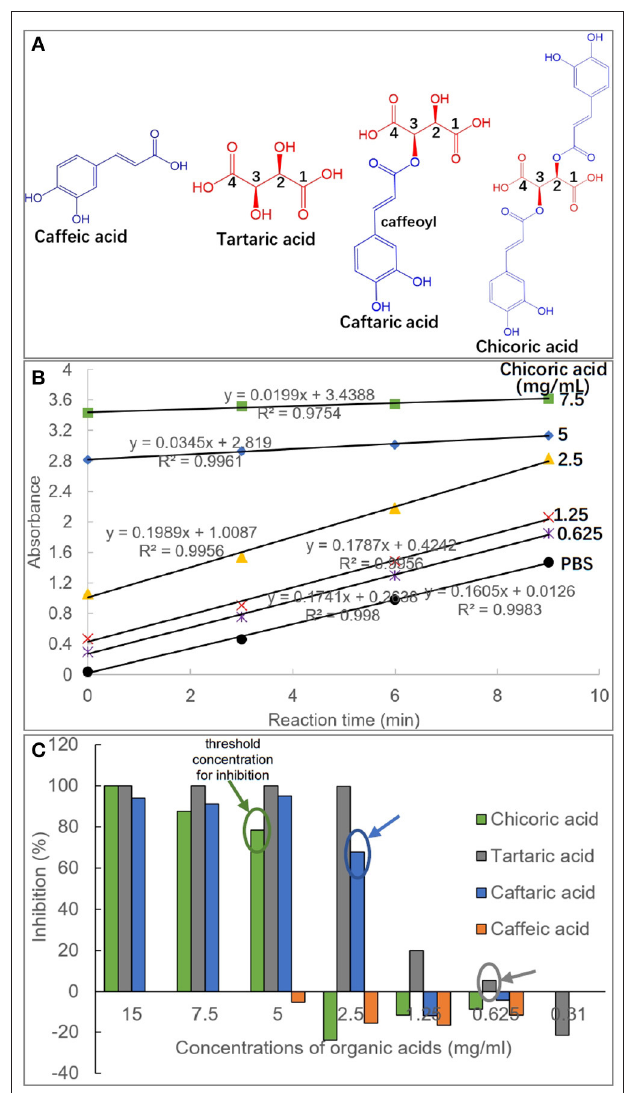
FIGURE 1 | Molecular structures of caffeic acid, tartaric acid, caftaric acid and chicoric acid, and the caffeic acid part in caftaric acid and chicoric acid is defined as caffeoyl moiety (A) . The plot of absorbance values of p NPG hydrolysis solution against reaction time (min) in the absence and presence of organic acids with different concentrations (taking chicoric acid as an example, and the plots for other organic acids were shown with similar profiles, except for caffeic acid due to its weak inhibitory activity) (B) . The initial reaction velocity ( v ) was calculated as the slope of the plot, and the enzyme inhibition effects (%) were obtained using equation (1) for the organic acids at a series of inhibitor concentrations (C) . Besides, the threshold concentrations of organic acids for the enzyme inhibition were